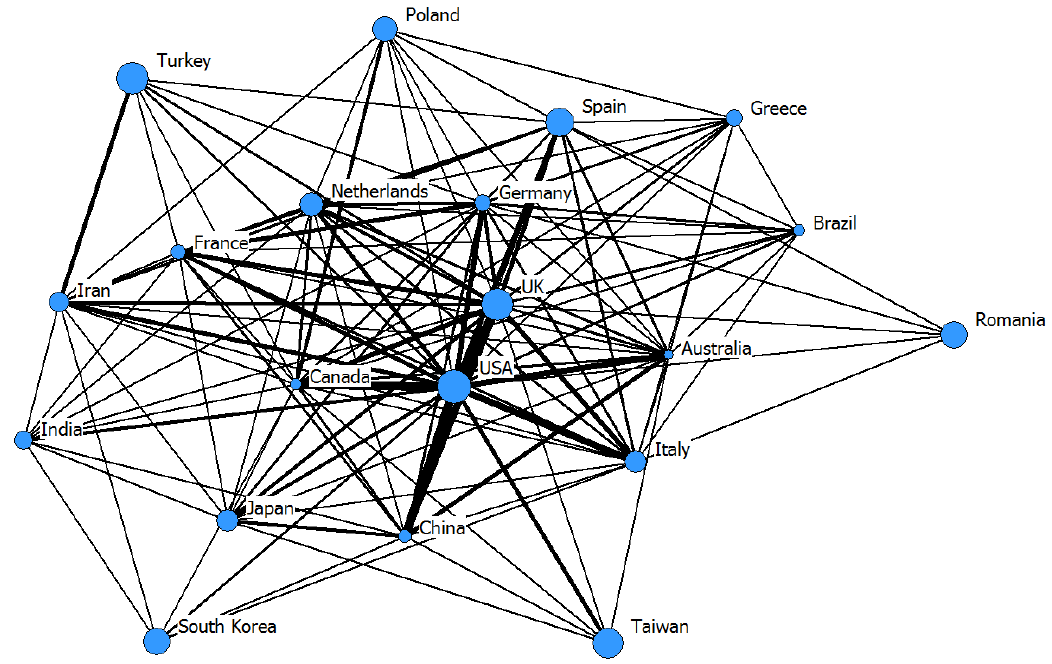
Figure 5. Core international collaboration networks.